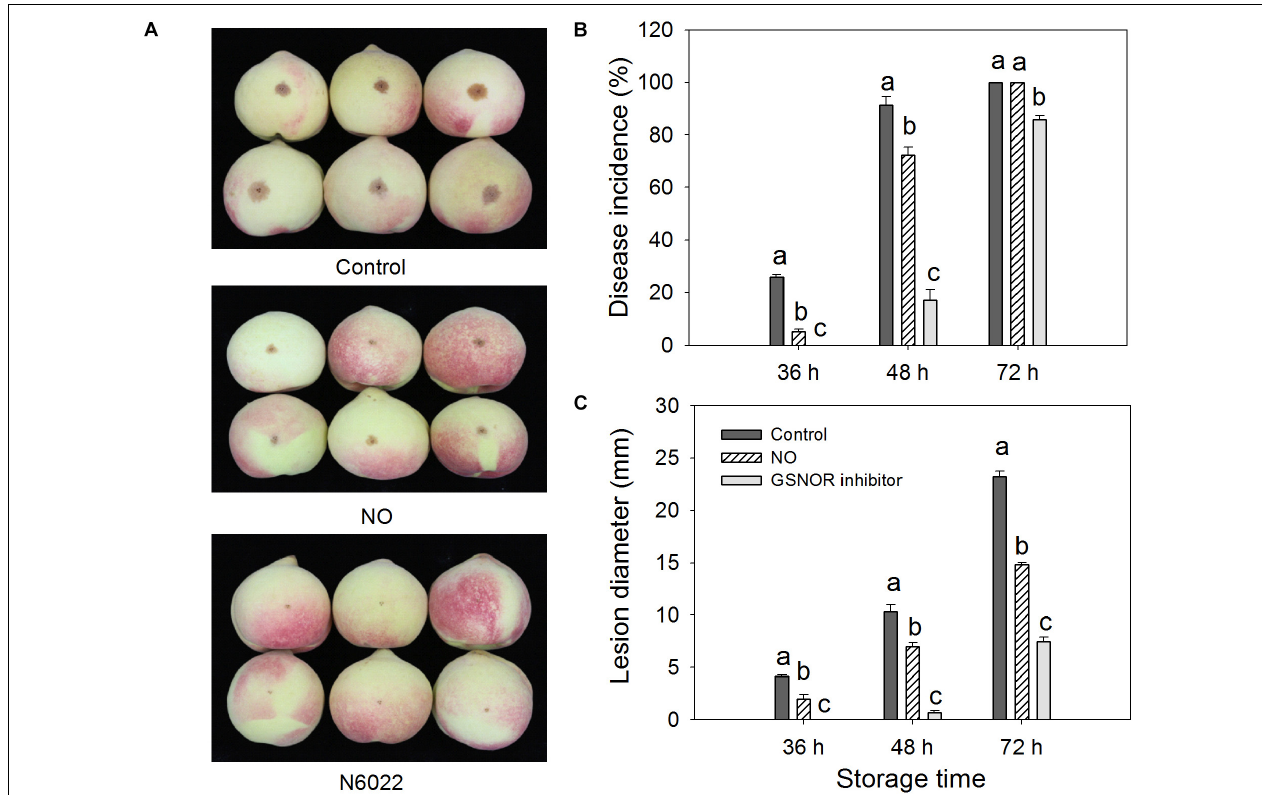
FIGURE 1 | Effect of nitric oxide (NO) or S -nitrosoglutathione reductase (GSNOR) inhibitor treatment on the (A) disease development (at 48 h after inoculation), (B) disease incidence, and (C) lesion diameter of peach fruit after inoculation with M. fructicola spore suspension (1 × 10 5 spores ml − 1 ) and then stored at 23 ◦ C. Bars represent standard deviations of the means ( n = 6). Different letters represent significant differences ( p < 0.05) according to least significant difference (LSD)